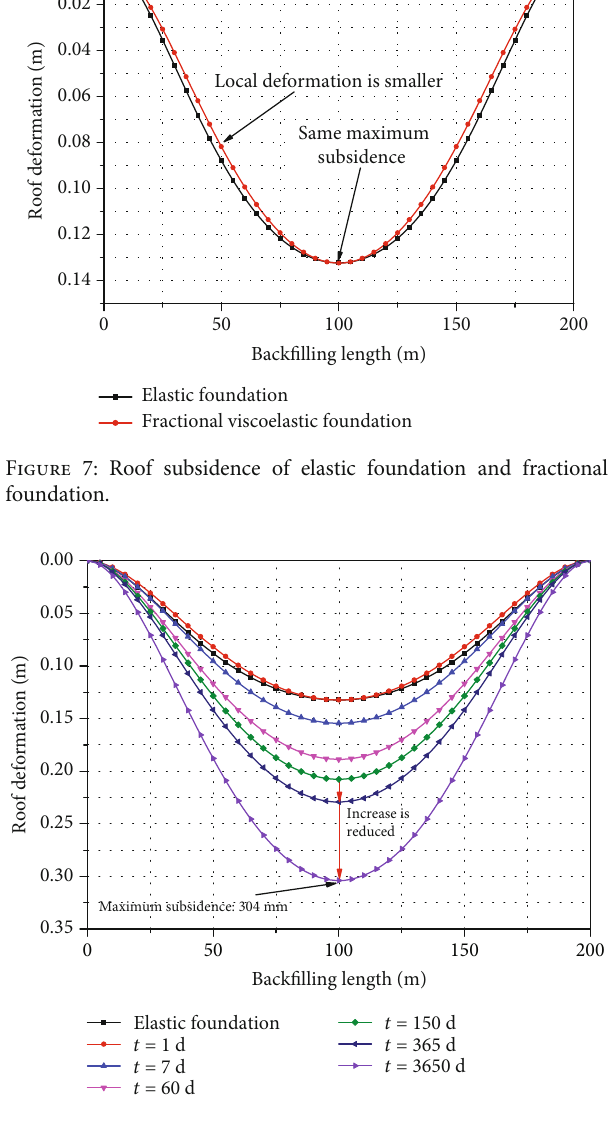
Figure 8: Roof subsidence with di ff erent